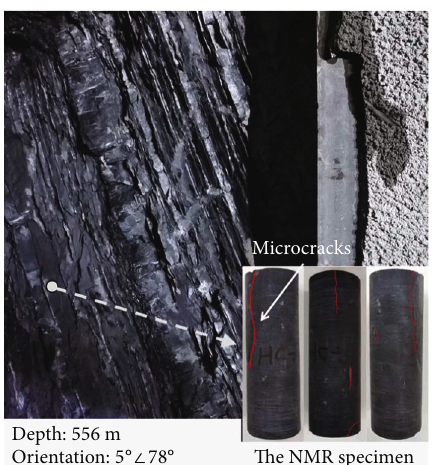
Figure 2: Surrounding rock and the NMR